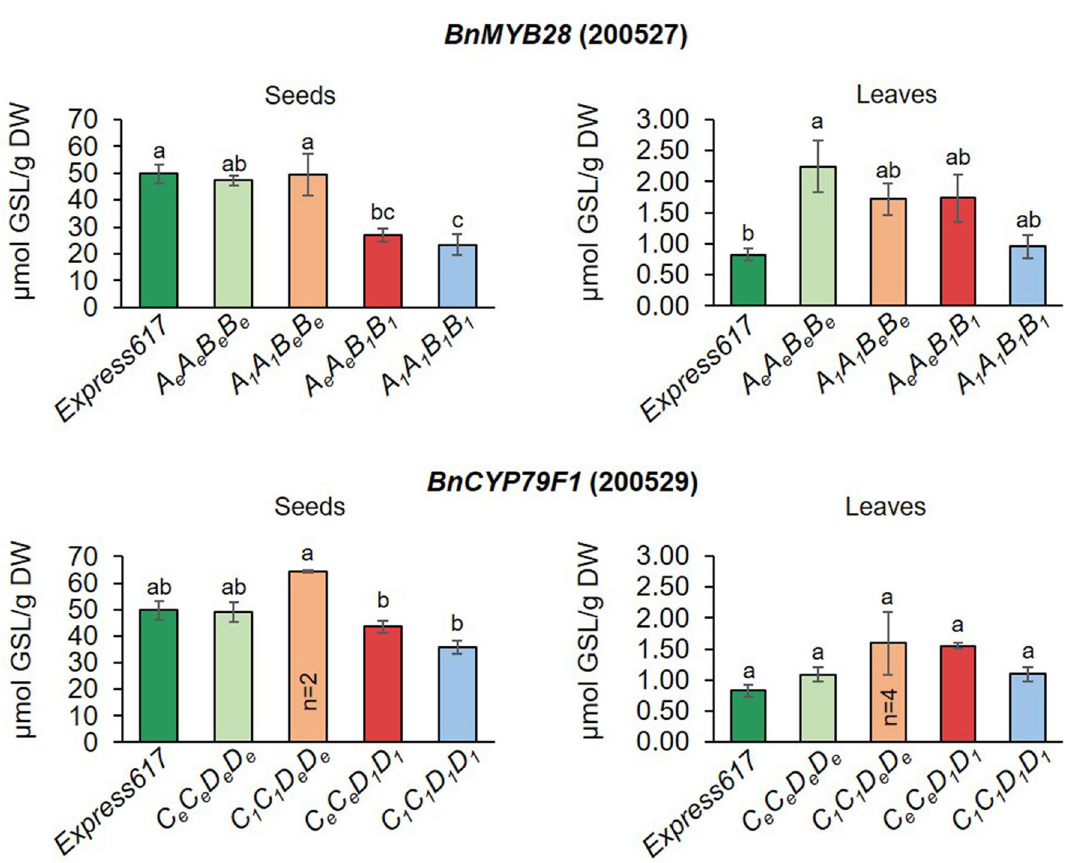
Figure 3. Seed and leaf glucosinolate contents in populations segregating for BnMYB28 and BnCYP79F1 mutations. F 2 populations 200527 and 200529 segregating for BnMYB28 and BnCYP79F1 mutations, respectively, originated from M 3 xM 3 crosses. Homozygous F 2 double mutants ( A 1 A 1 B 1 B 1 and C 1 C 1 D 1 D 1 ) were analyzed together with homozygous single mutants ( A 1 A 1 B e B e , A e A e B 1 B 1 , C 1 C 1 D e D e, and C e C e D 1 D 1 ), non-mutagenized Express617 and F 2 plants homozygous for the wildtype alleles ( A e A e B e B e and C e C e D e D e ). Leaf samples were taken 15 days after pollination and mature seeds (BBCH89) were used for glucosinolate determination. Error bars represent the standard error from five plants (n = 5) per genotype with two exceptions mentioned in the figure. An ANOVA ( p < 0.05) was performed and the Tukey test ( p < 0.05) was done for grouping. Different alphabets above error bars represent groups based on significance. All genotypes are as per designated allele codes given in Table